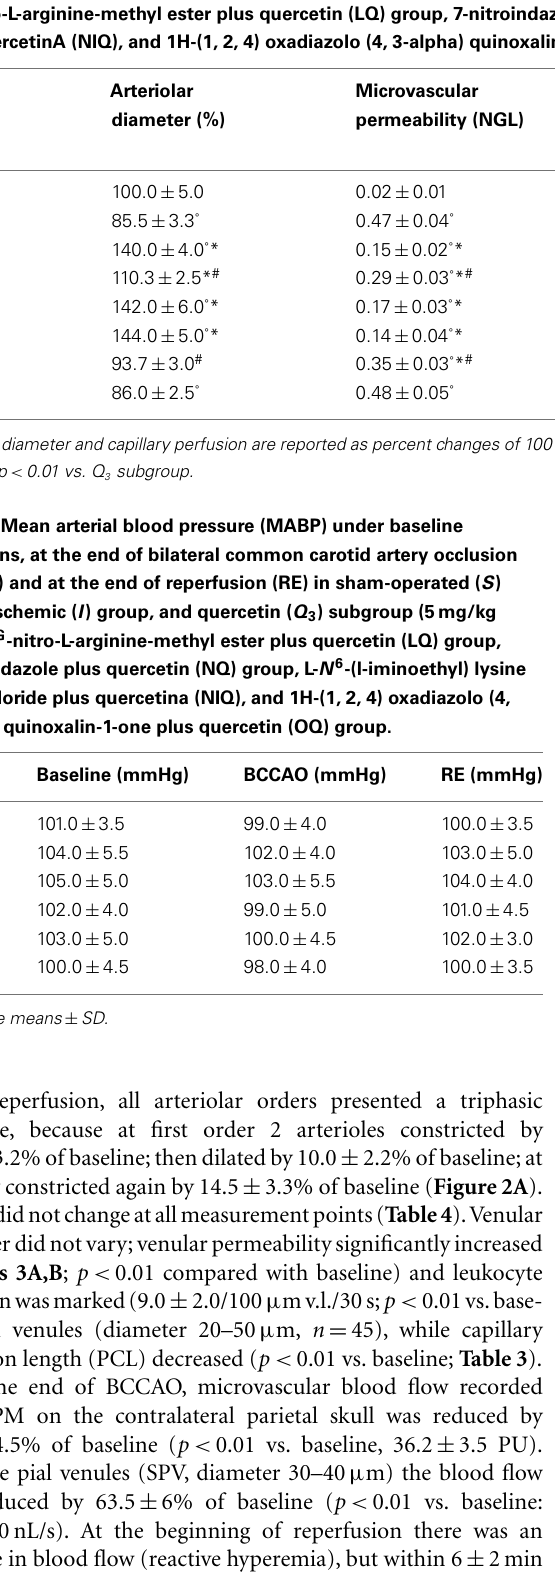
Table 3 |Variations of the main parameters in sham-operated ( S ) group, ischemic ( I ) group, and quercetin ( Q 3 ) subgroup (5mg/Kg b.w.), N G -nitro-L-arginine-methyl ester plus quercetin (LQ) group, 7-nitroindazole plus quercetin (NQ) group, L- N 6 -(l-iminoethyl) lysine hydrochloride plus quercetinA (NIQ), and 1H-(1, 2, 4) oxadiazolo (4, 3-alpha) quinoxalin-1-one plus quercetin (OQ) group at the end of reperfusion.